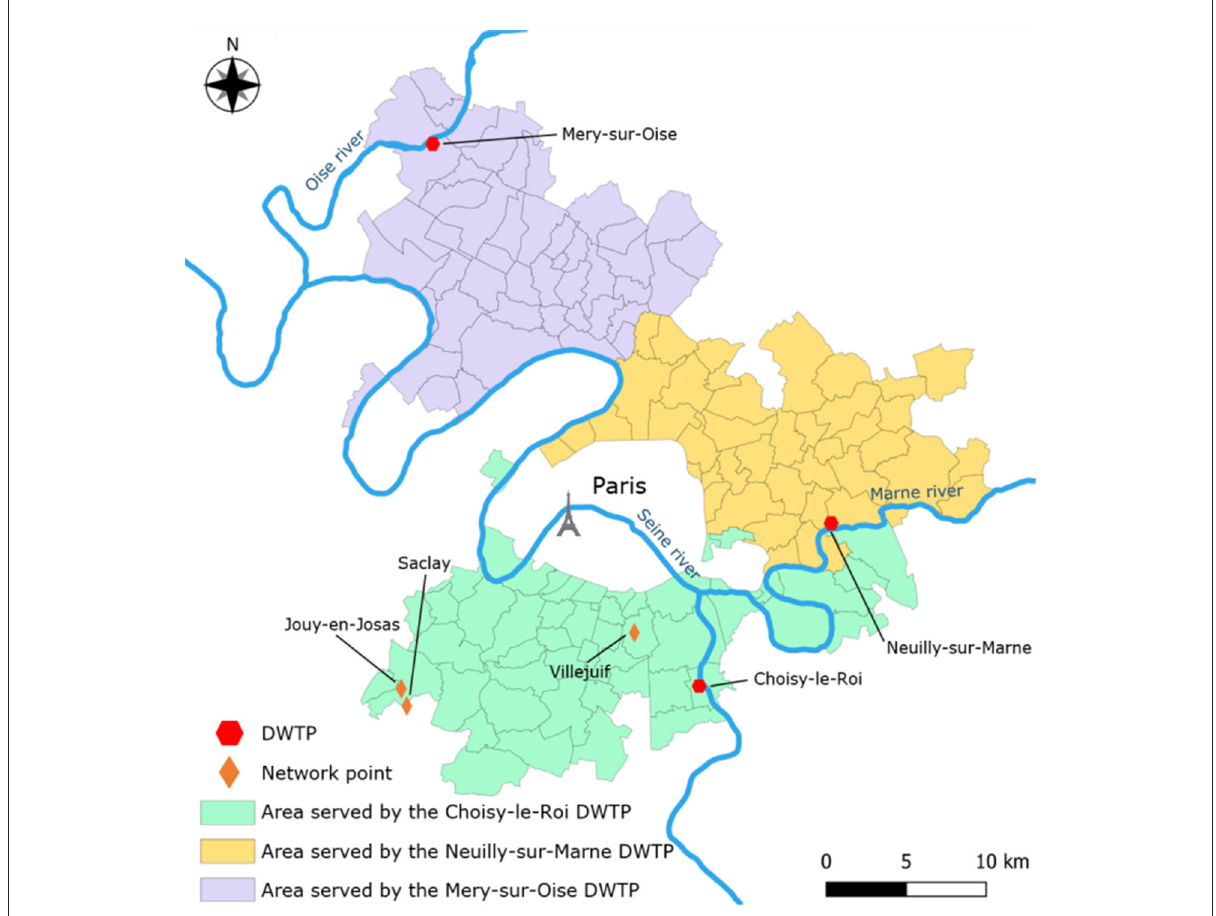
FIGURE1 Map of the sampling sites and area served by the drinking water treatment